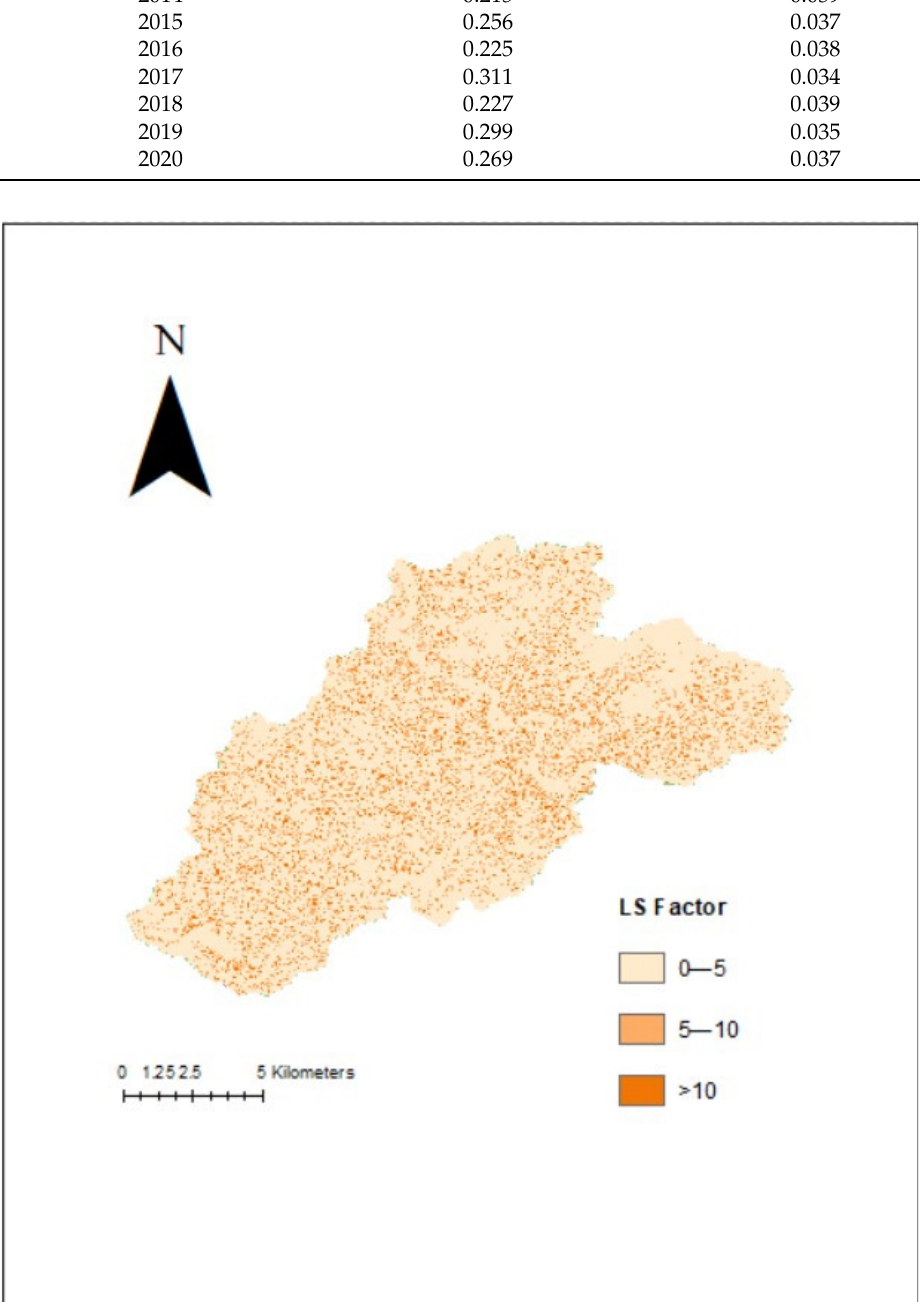
Figure 4. Map representing the L.S. Factor values across the watershed.